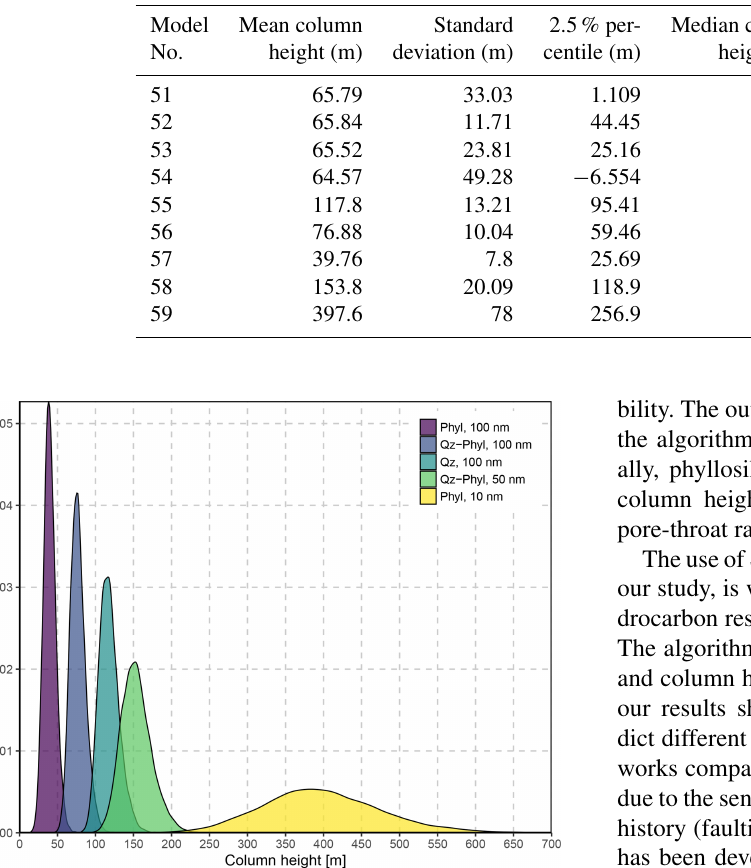
Figure 7. The density distribution of column heights of models 55 to 59 illustrates the role of fault rock composition and pore- throat size on supported column heights. If the pore-throat size is the same, phyllosilicate-rich fault rocks can only support low col- umn heights compared to quartz-rich fault rocks. If the pore size decreases with increasing phyllosilicate content, the column height increases with increasing phyllosilicate content. However, the in- crease in column heights is significantly less than the 1 order of magnitude expected due to the change in pore-throat size. This is due to CO 2 wettability depending on fault rock composition, which results in phyllosilicate-rich fault rocks supporting a lower col- umn than quartz-rich fault rocks with a similar pore throat. Column height is calculated using Eq. (3) and a CO 2 density of 515kgm − 3 (as reservoir A). For all five models N =